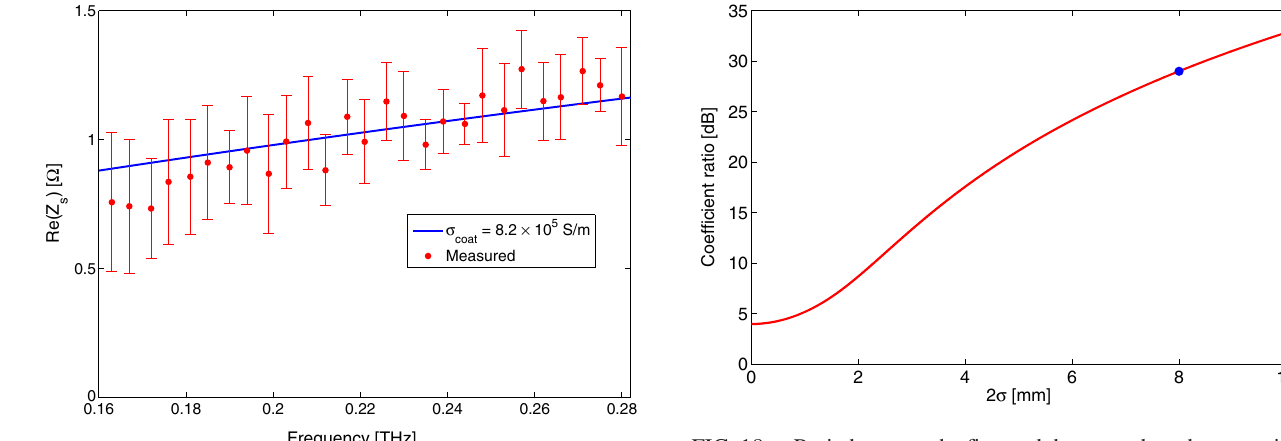
FIG. 18. Ratio between the first and the second mode expansion coefficients as a function of the beam spot size ( 2 σ